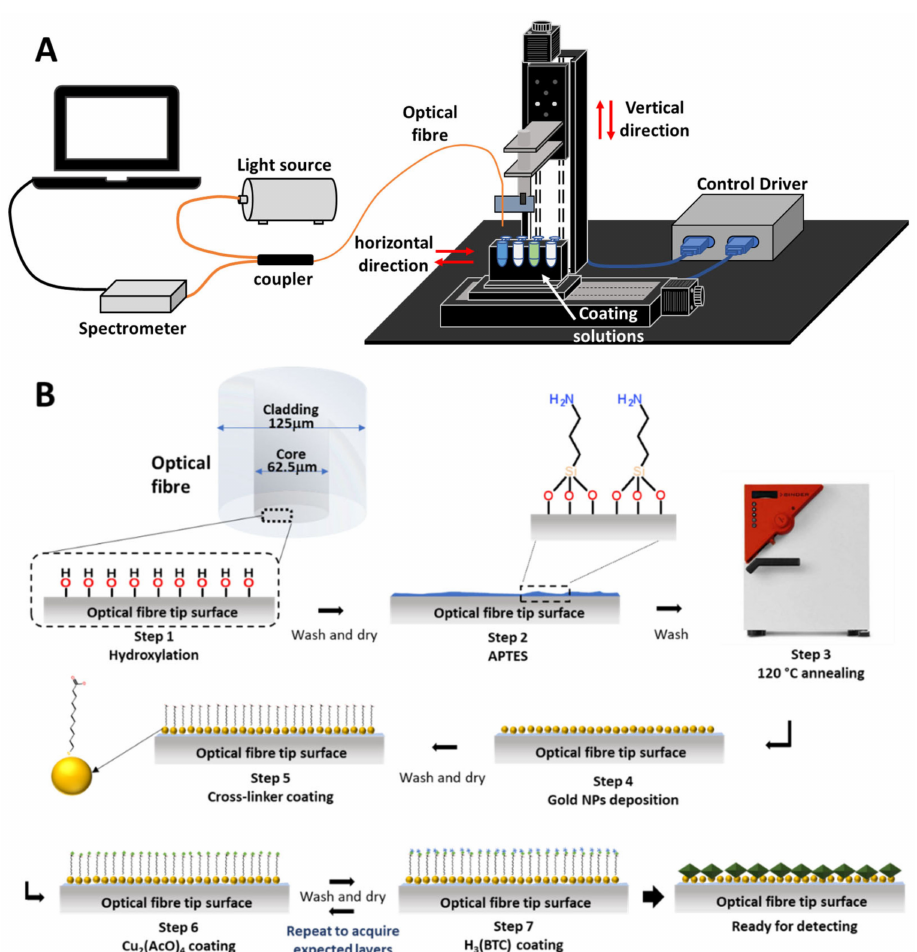
Figure 2. ( A ) Experimental set-up of the MOF layer-by-layer coating process. ( B ) Schematic illustration of sensor fabrication.